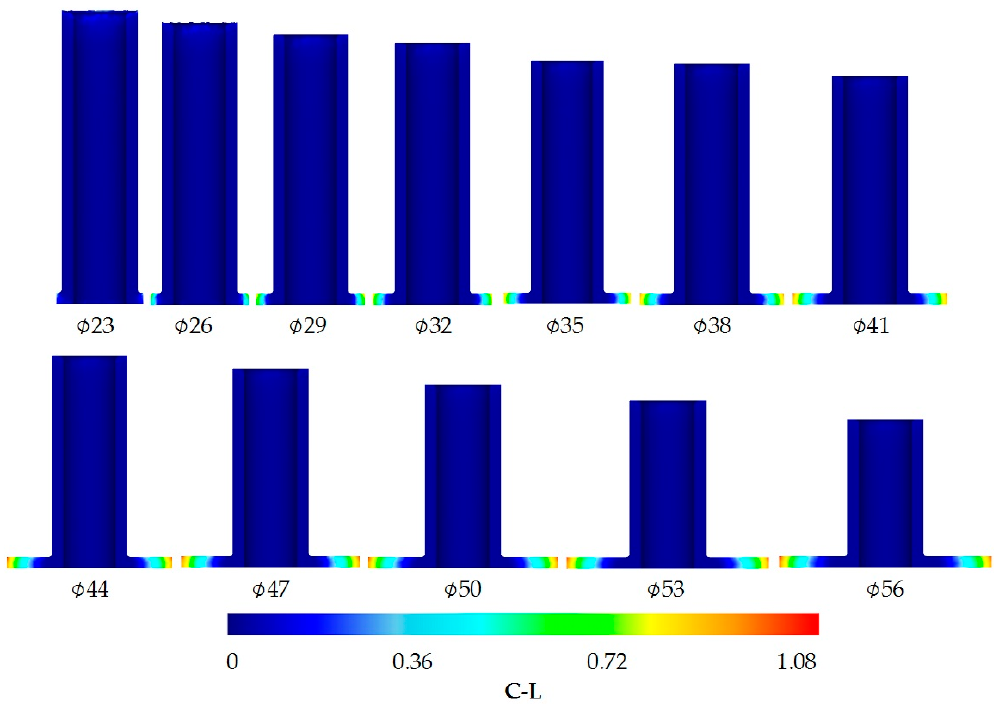
Figure 7. Distribution of the normalized Cockcroft–Latham ductile fracture criterion.